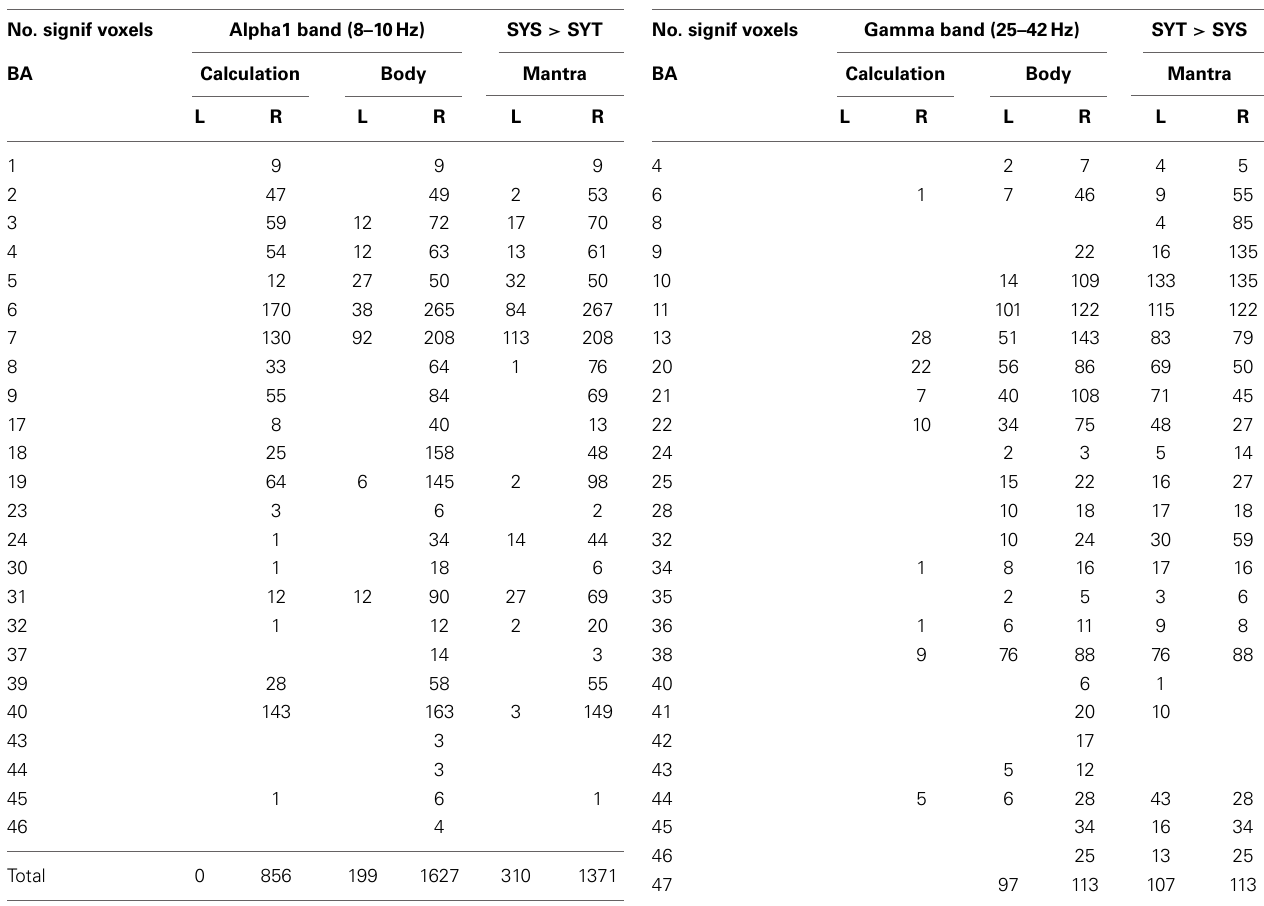
Table 4 | Number of significant voxels in each Brodmann Area for each condition in alpha1 band.